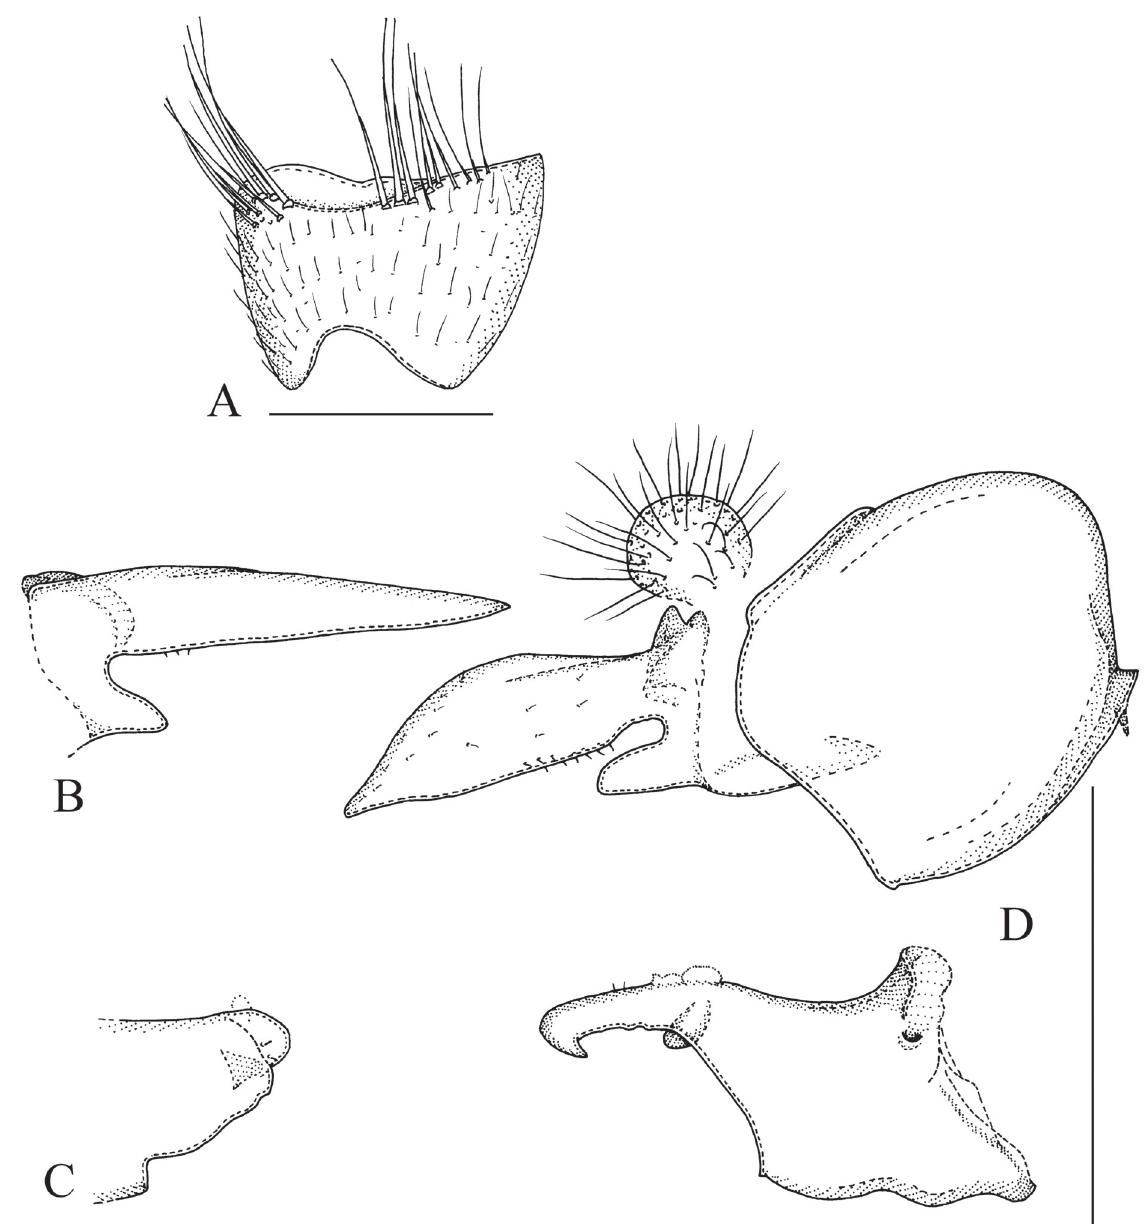
Fig. 40. Sphegina (Asiosphegina) hamulata sp. nov., holotype, ♂ . A . Sternum IV, ventro-lateral view. B . Left surstylus, lateral view. C . Left super ior lobe and associated parts, lateral view. D . Genitalia, right side, lateral view. Scale bars = 0.5